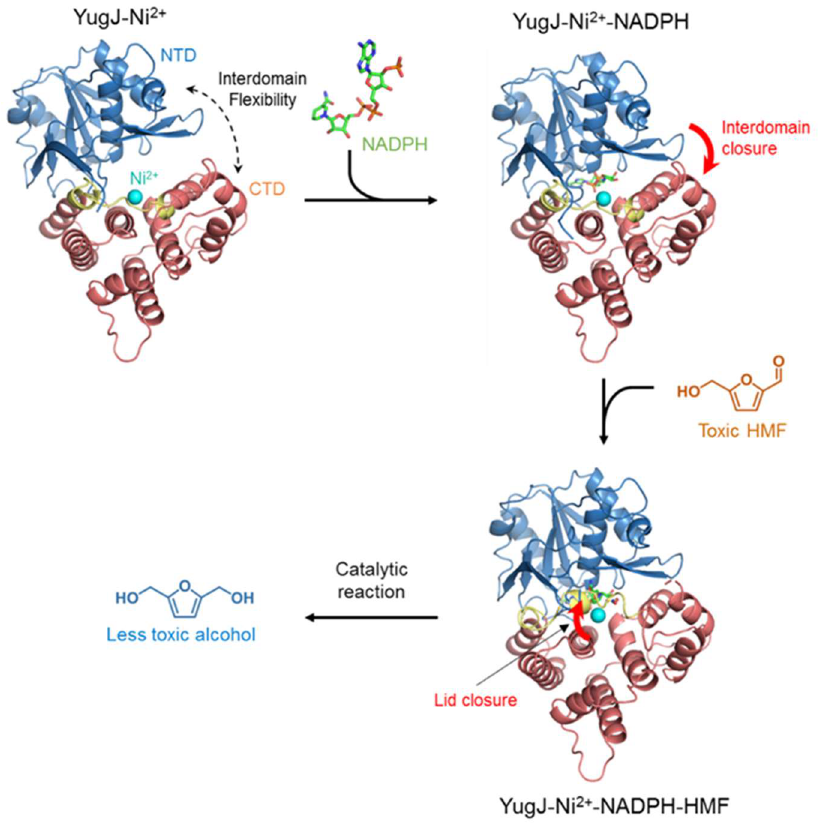
Figure 6. A model for YugJ binding to NADPH and HMF. The YugJ NTD and CTD are shown as blue and red ribbons, respectively, and the α9–α10 loop lid in the CTD is highlighted in yellow. The NADPH and Ni 2+ cofactors are depicted as green sticks and a cyan sphere, respectively. NADPH and HMF binding-induced structural changes in YugJ are represented by thick red arrows.